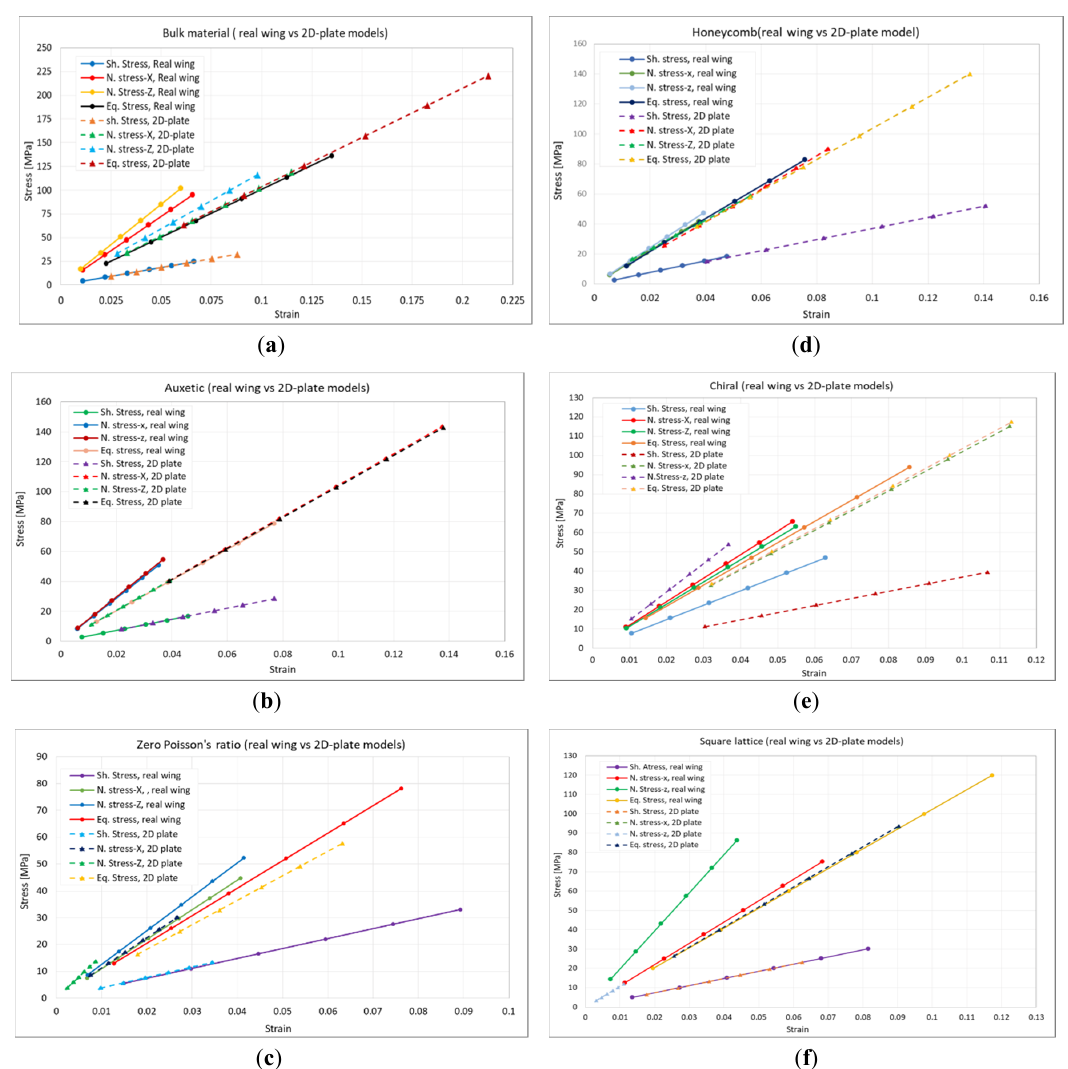
Figure 18. Relationship between 3D wing model and 2D-plate models (comparison result). ( a ) Actual 3D wing result vs. 2D plate model in corresponding stress and strains, ( b ) Auxetic lattice structure and its S-S curve, ( c ) Zero-Poisson ratio lattice structure and its S-S curve, ( d ) Honeycomb lattice structure and its S-S curve, ( e ) Chiral lattice structure and its S-S curve, (f) Square lattice structure and its S-S curve.